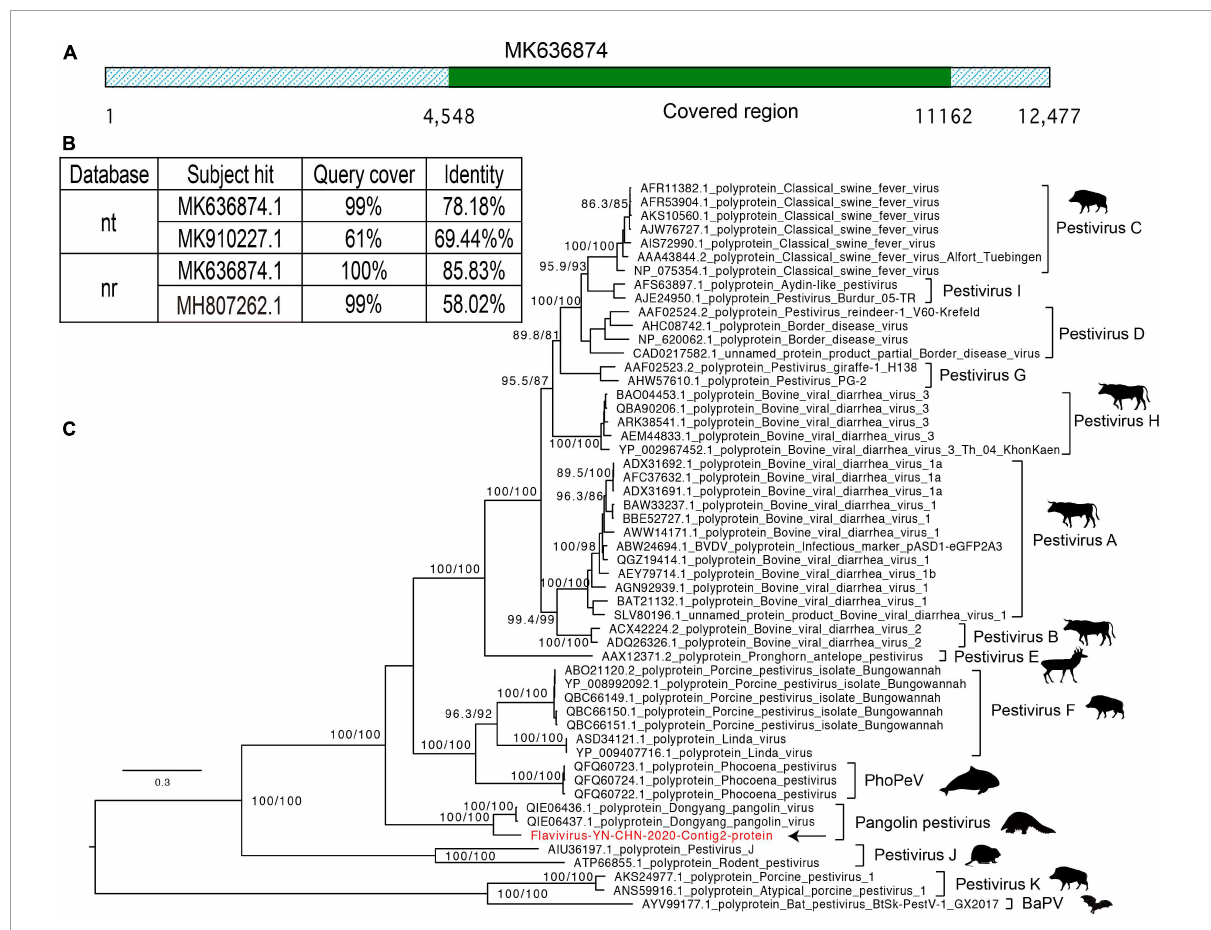
FIGURE4 Characterization of the pestivirus genome contigs. (A) Graphics of mapped sequences. (B) The top two hits in the nucleotide (NT) and protein (NR) databases using the BLASTN and BLASTP algorithms. (C) Maximum likelihood tree of the newly identified pestivirus species, neighboring genomes, and newly identified flavivirus, based on the amino acid sequences. The scale bars show the substitutions per site per year, and the values at each node indicate the bootstrap and SH-like approximate likelihood ratio tests (SH-aLRT), with 1,000 bootstrap replicates. The black arrows represent the newly identified